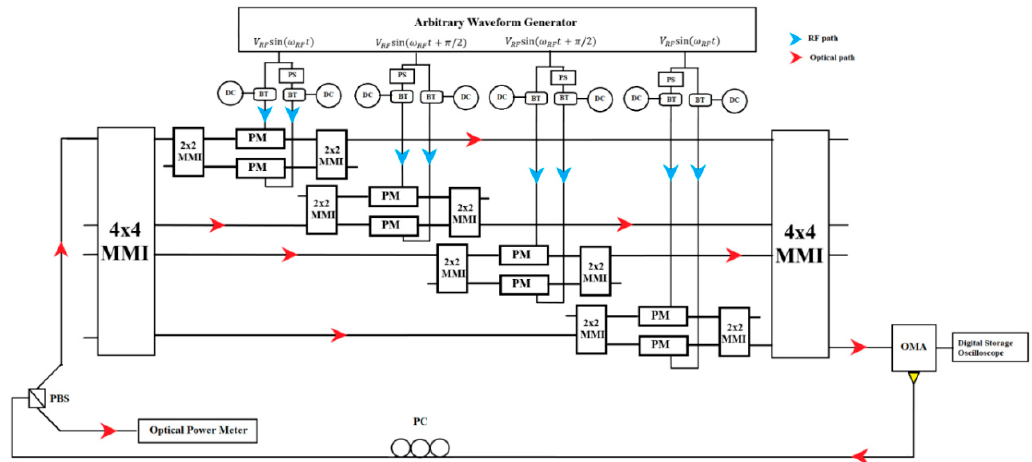
Figure 5. Schematic of the experimental setup. OMA, optical modulation analyzer; PC, polarization controller; PBS, polarization beam splitter; PM, phase modulator; BT, bias tee; PS, phase shifter. The phase modulators are of equal length.